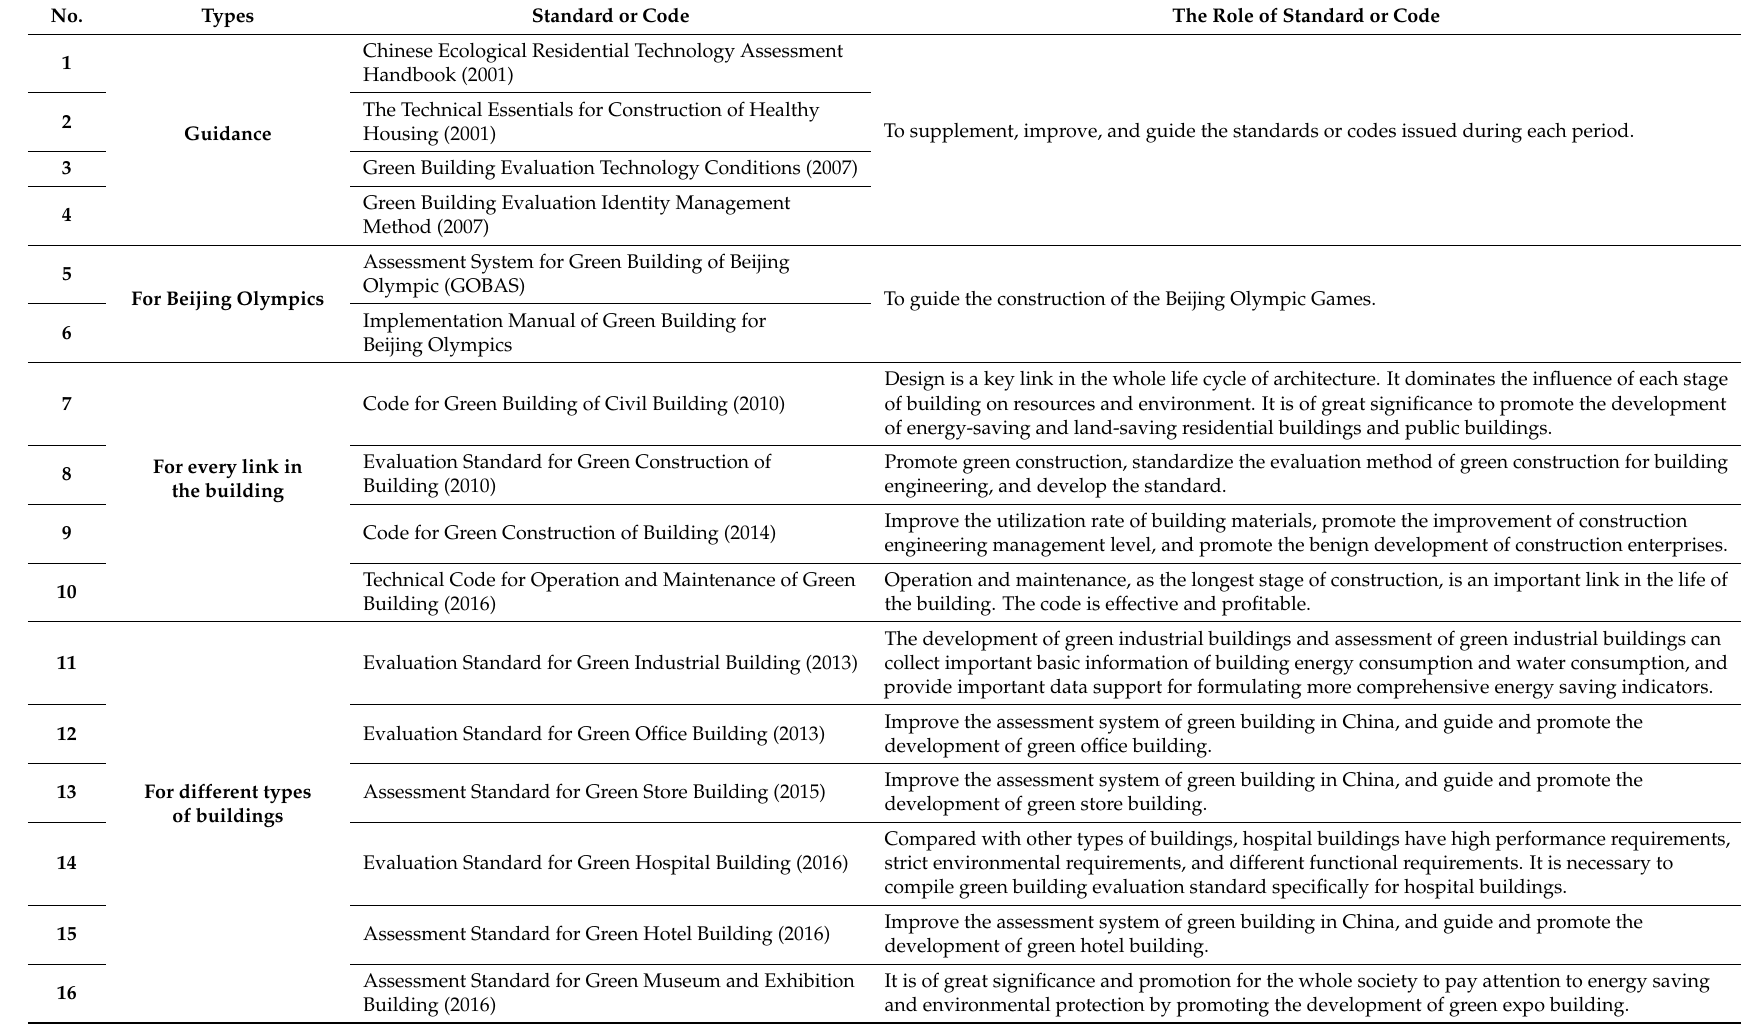
Table 1. The roles and relations of standards or